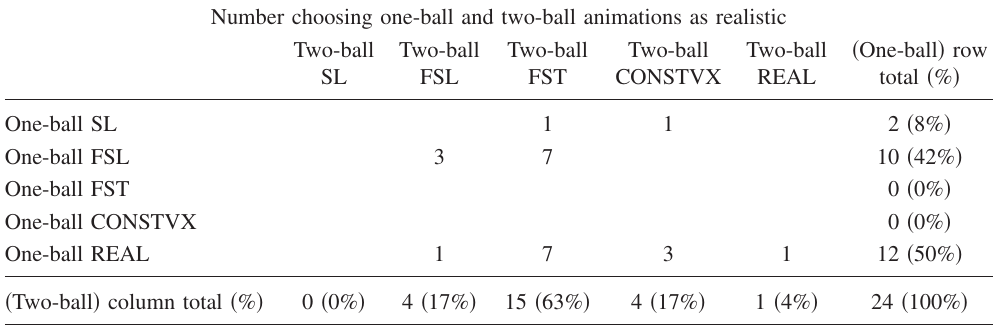
TABLE II. Animation preferences for one- and two-ball tasks; 24 students from introductory calculus- based physics (cid:1) honors (cid:2) course. Number choosing one-ball and two-ball animations as realistic